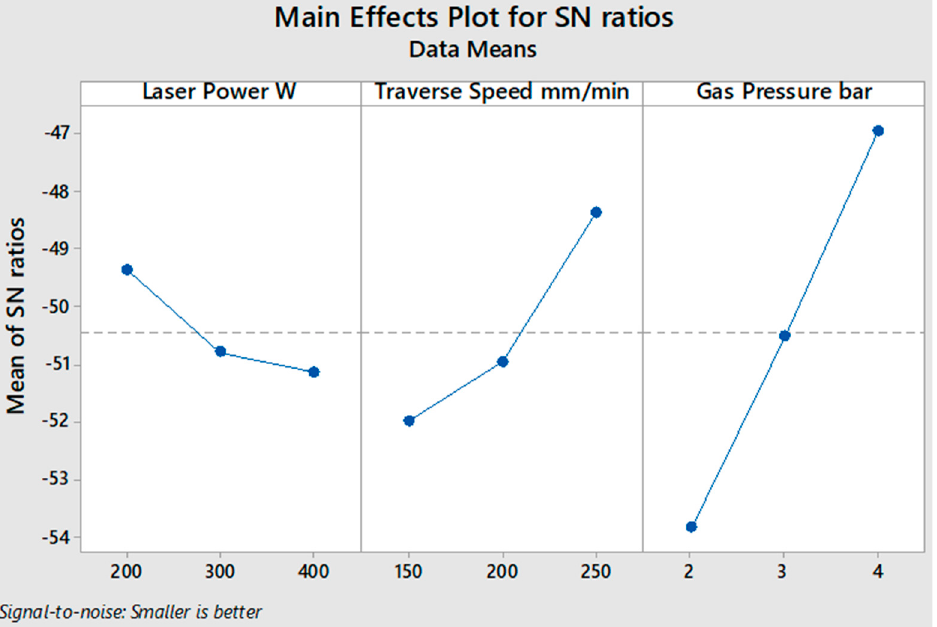
Figure 3. S / N ratio smaller-is-better average value of input cutting parameters of the 2 mm thick sugar palm fiber reinforced unsaturated polyester (SPF-UPE) composite. Table 4. L9 array of input parameter levels with measured HAZ and calculated signal-to-noise ( S / N ) Table 5. S / N ratio smaller-is-better response table of input cutting parameters of the 2 mm thick SPF-UPE. ratio according to the Taguchi method for 2 mm specimen thickness.